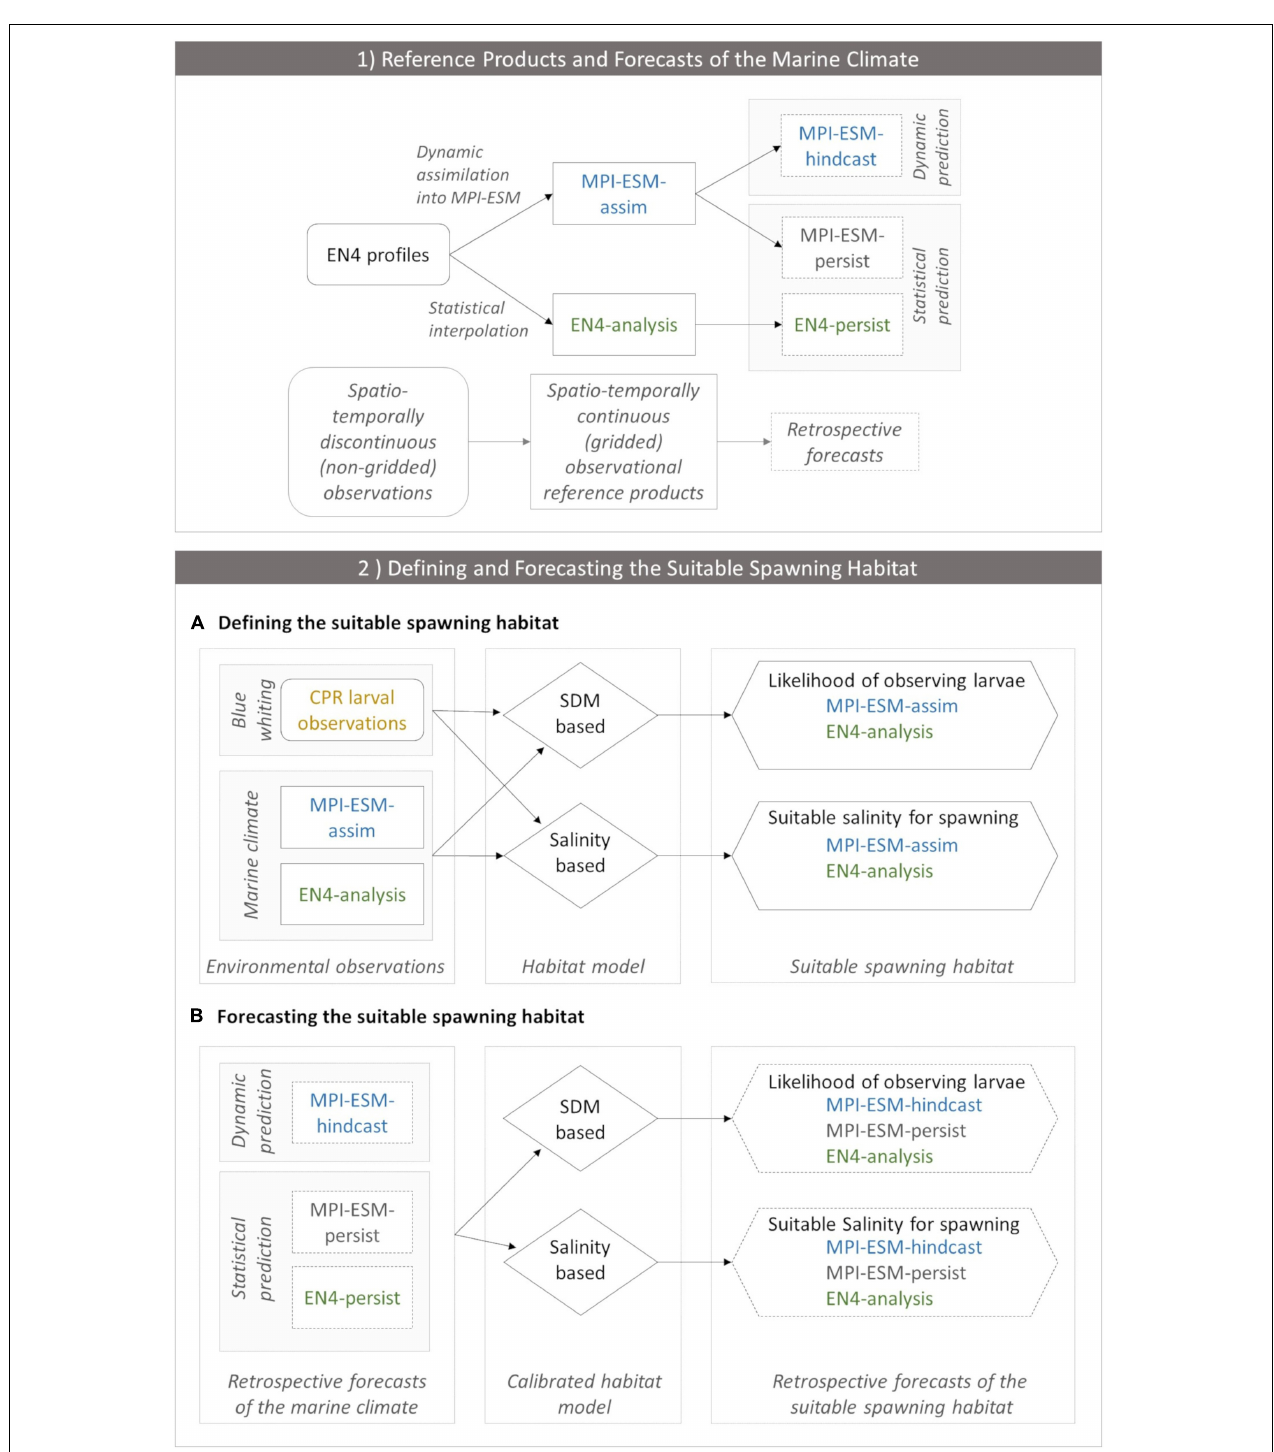
FIGURE 2 | (1) Observational reference products of the marine climate ( EN4-analysis and MPI-ESM-assim; solid boxes) and the corresponding retrospective forecasts (dashed lines) employed in the study and (2) the workflow of defining (A) and forecasting (B) the suitable spawning habitat of blue whiting. In panel (1) EN4 profiles (rounded box) contain spatio-temporally discontinuous (non-gridded) observations of the marine climate. In order to create spatio-temporally continuous (gridded) observational reference products, either EN4 profiles are assimilated into MPI-ESM resulting in MPI-ESM-assim or EN4 profiles are statistically interpolated forming the EN4-analysis. Thereby, both MPI-ESM-assim and EN4-analysis contain the same non-gridded oceanographic observations (EN4 profiles) but their methods to close observational gaps differ. These observational reference products form the basis for retrospective forecasts of the marine climate.